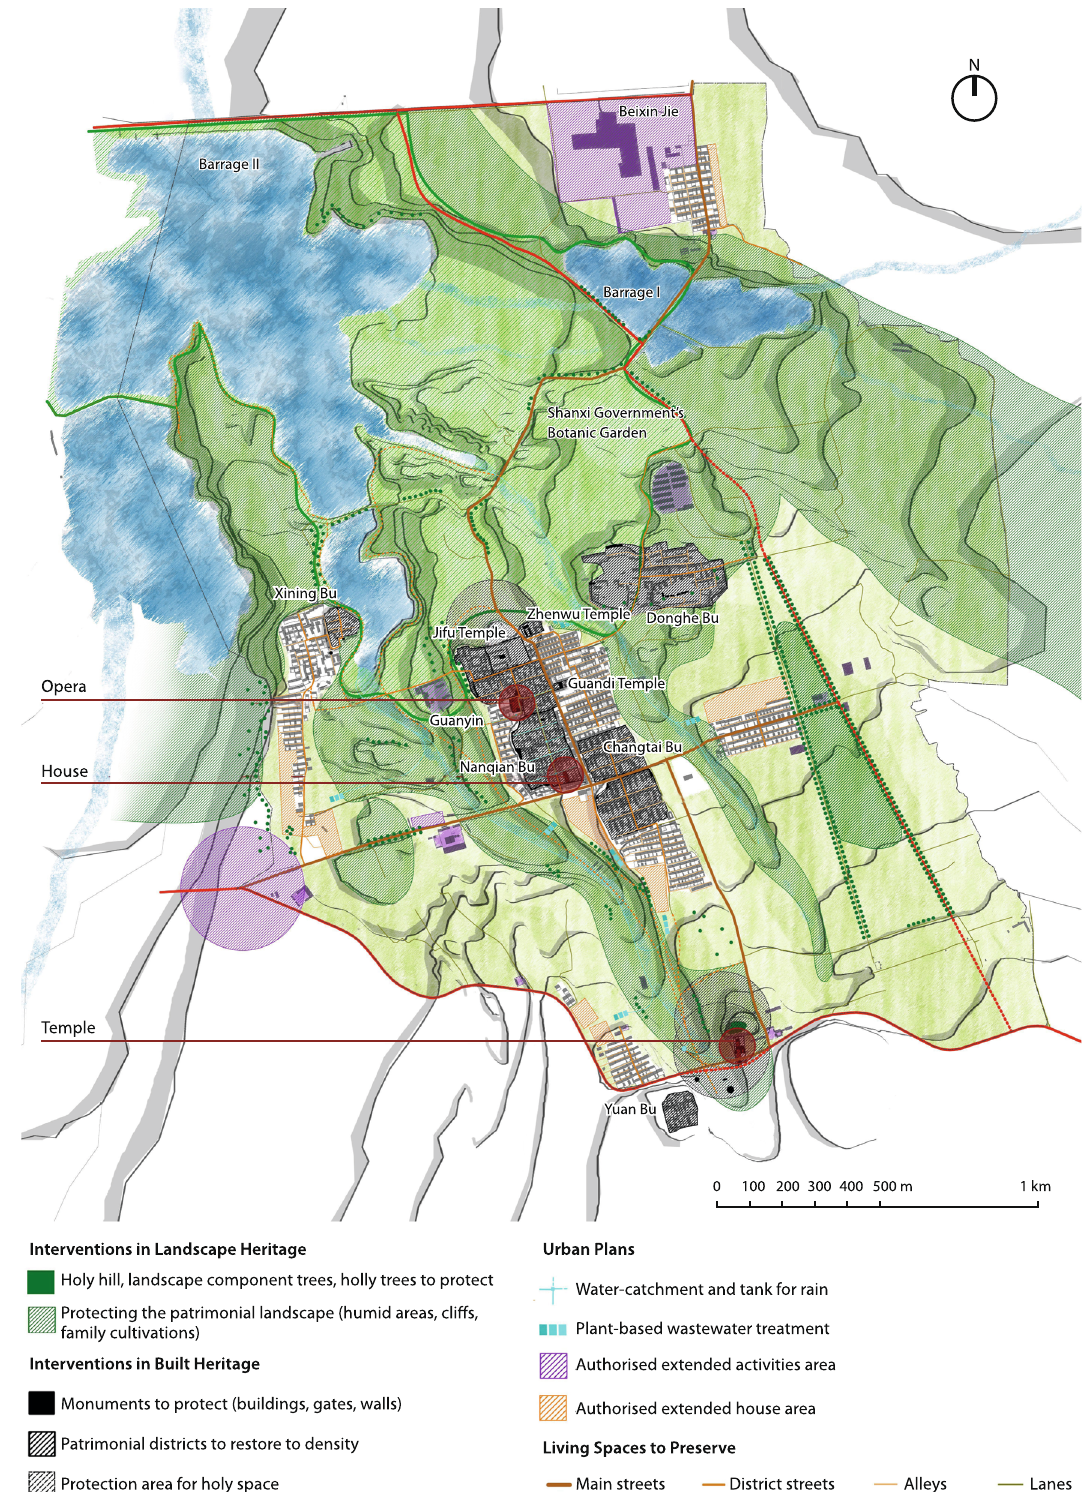
Fig. 18 Conservation and development plan of Liang Village (Source: Tongji University and Ecole de Chaillot